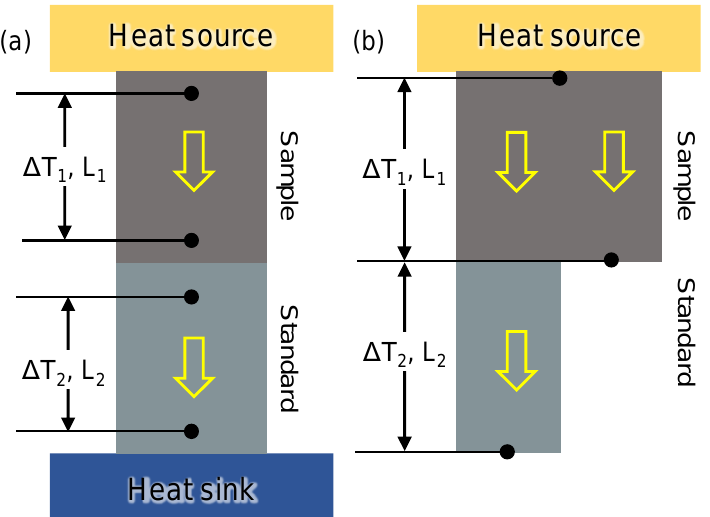
Figure 2. Schematic of the setup used for measuring the thermal conductivity using ( a ) original and ( b ) modified comparative cut bar technique.